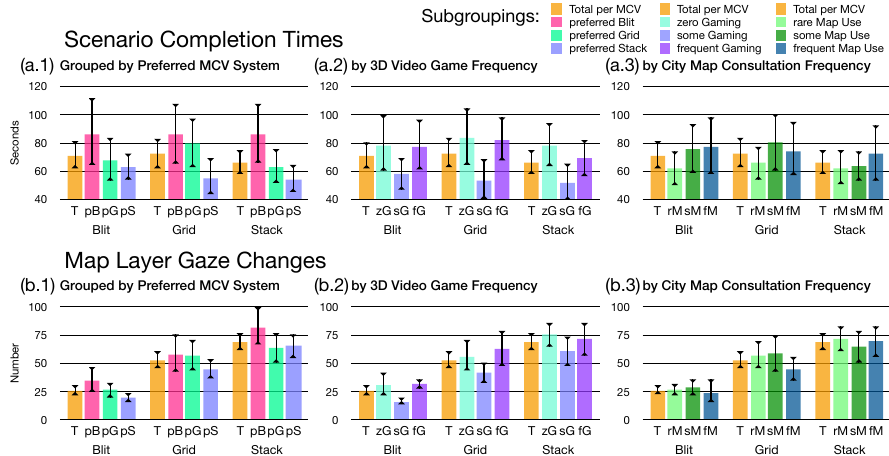
Figure 8. Performance measurements for each MCV system (blit/grid/stack): scenario completion times ( a ), and the number of times gaze has shifted from one map to another per scenario ( b ). Further subgrouped by the participants’ preference for an MCV system regarding its legibility (1), the frequency with which they play video games (2), and the frequency with which they consult city maps